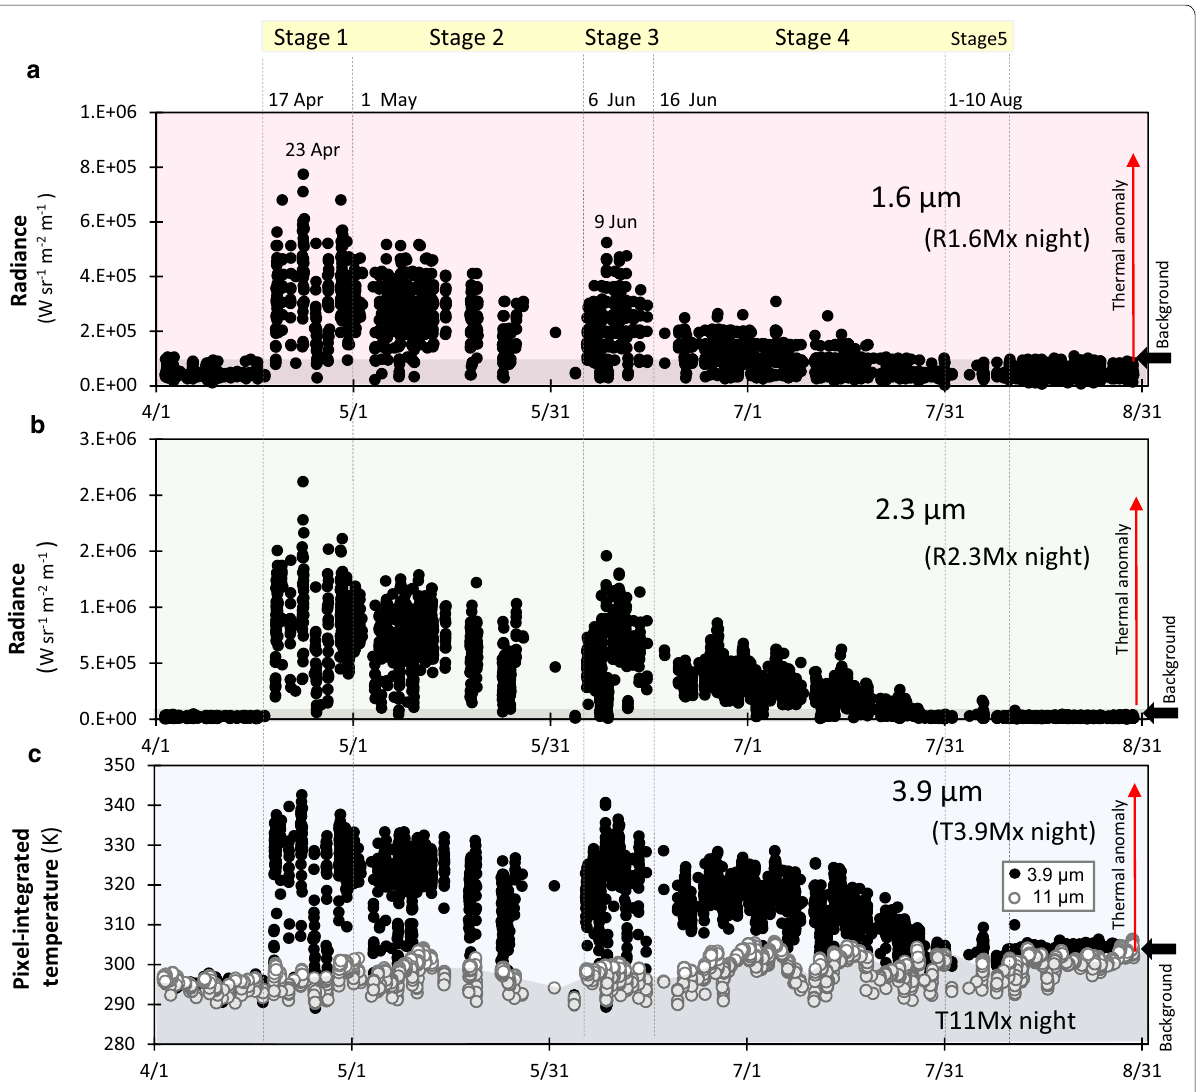
Fig. 3 a Time-series variation of nighttime maximum spectral radiance at 1.6 µm (R1.6Mx). b Time-series variation of nighttime maximum spectral radiance at 2.3 µm (R2.3Mx). c Time-series variation of nighttime maximum pixel-integrated temperature at 3.9 µm (T3.9Mx: closed circles) and 11 µm (T11Mx: open